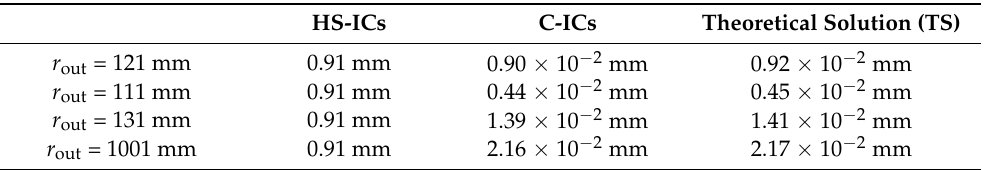
Table 2. Comparison of average radial displacement of cylindrical shell under unit uniform internal